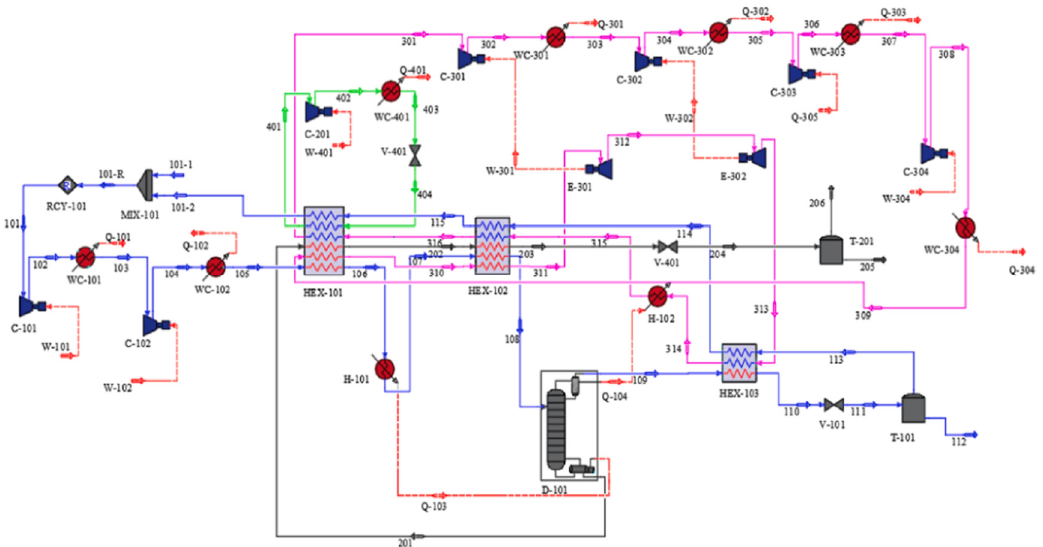
Figure 25. Mixed refrigerant N 2 -CH 4 expansion liquefaction process integrated with ethane separation for high ethane-content natural gas [91]. Reproduced with permission from Elsevier (license number